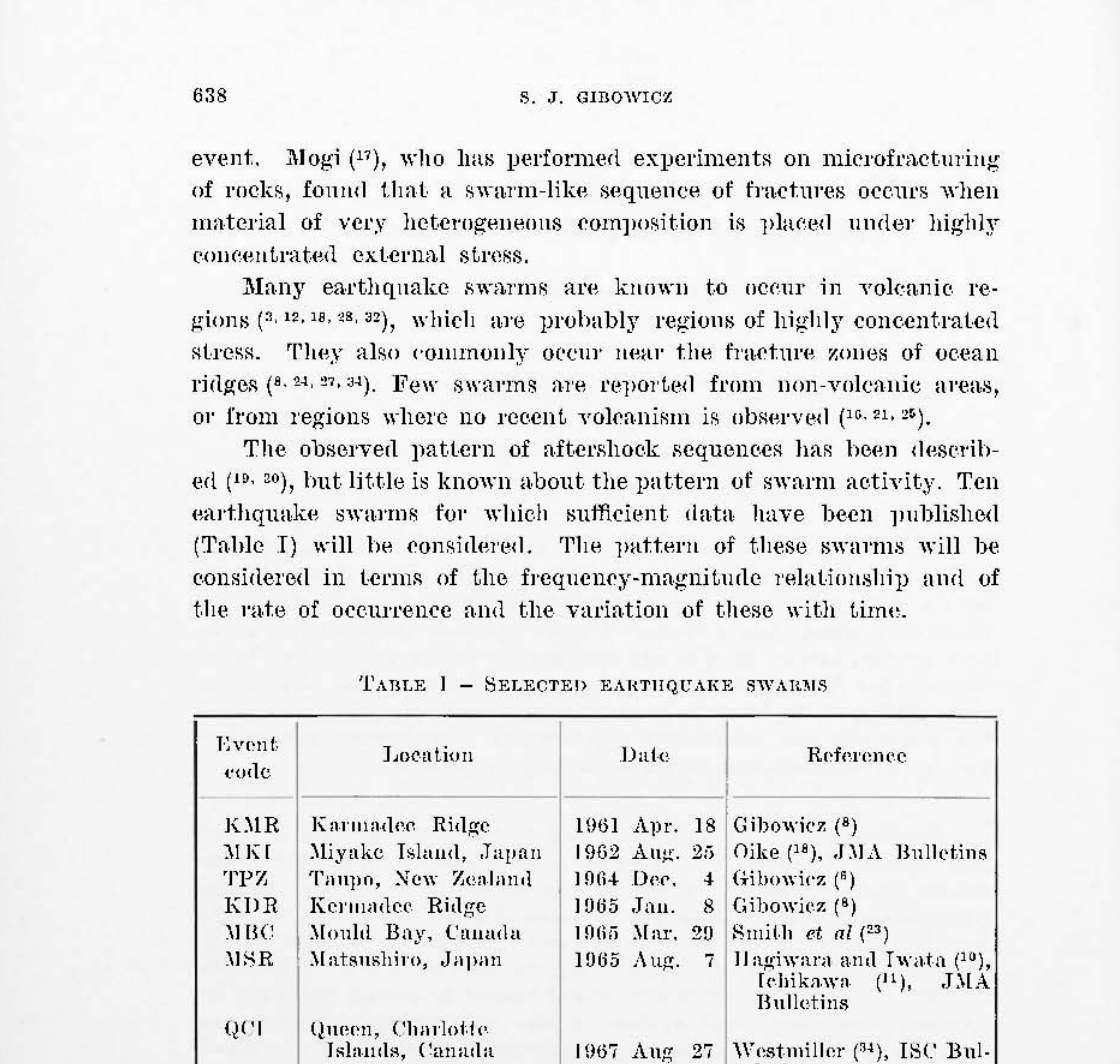
TABLE I - tlELECTED EAHTllQl:AIi:E